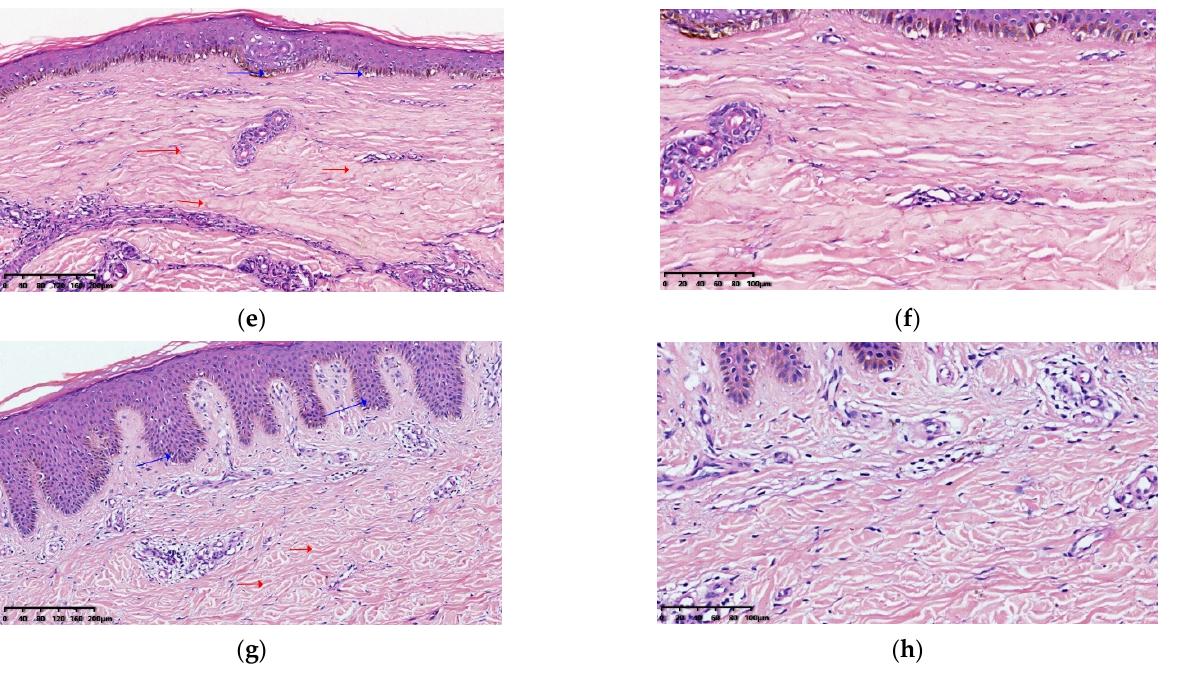
Figure 4. The microscopic appearance of a patient’s H&E-stained sections in the treatment region. ( a ) (×100) and ( b ) (×200) are the H&E-stained sections of a patient in the AFL+MTX group before treatment. Dense collagen deposition is shown with red arrows. Perivascular and periappendageal moderate admixed inflammatory cell infiltration is shown with blue arrows. ( c ) (×100) and ( d ) (×200) are the H&E-stained sections of the patient one month after four treatments. Decreased collagen deposition and a widened collagen gap are shown with red arrows. Mild admixed inflammatory cell infiltration is shown with blue arrows. ( e ) (×100) and ( f ) (×200) are the H&E-stained sections of a patient in the AFL group before treatment. Epidermal atrophy and vacuolar degeneration of the basal cell layer are shown with blue arrows. Thickish collagen fibers and a narrow collagen gap are shown with red arrows. ( g ) (×100) and ( h ) (×200) are the H&E-stained sections of the patient one month after four treatments. Thicker epidermis and marked elongation rete ridges are shown with blue arrows. Thinner collagen fibers and a wider collagen gap are shown with red arrows.